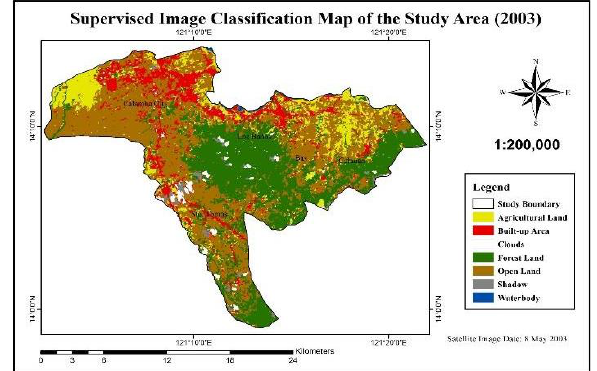
Figure 4. Supervised image classification of the study area